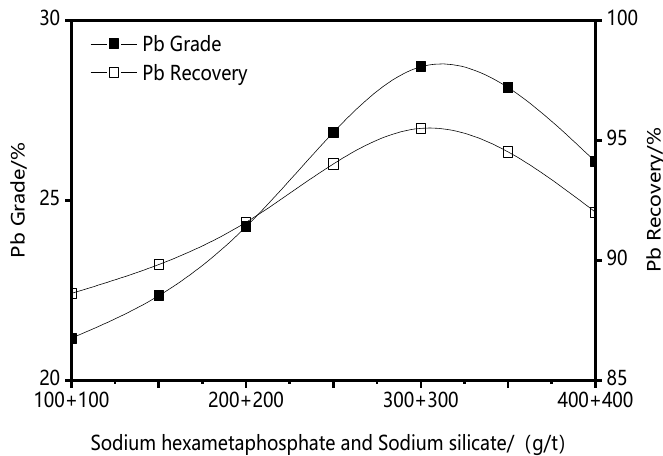
Figure 6. The influence of Na 2 SiO 3 and (NaPO 3 ) 6 dosage on Pb rougher flotation.